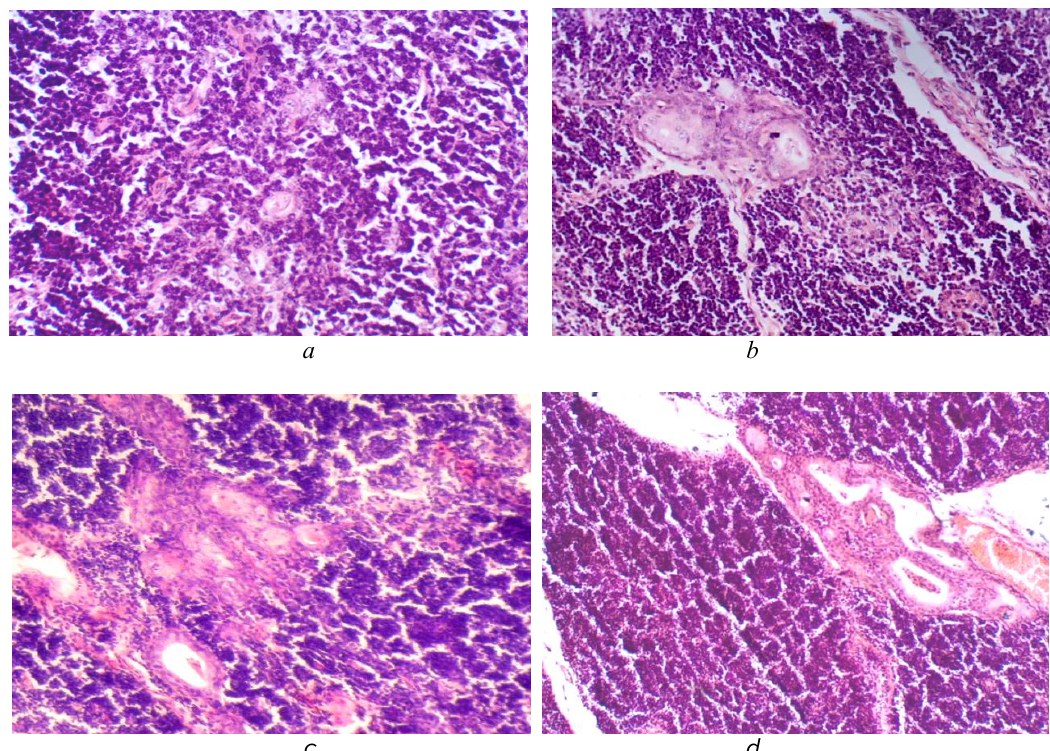
Fig. 1. Structure of the thymus of rats on the 18th day of the IC: a – thymus of rats IR; b – thymus of rats of CP; c – the thymus of rats against the background of the effect of TEPL at a dose of 100 mg/kg: d – thymus of rats against the background of the action of the preparation “Immuno-Ton” in a dose of 3 ml/kg Histologically, it was found that the lumbar structure few thymus cells (Fig. 1, a). In fig. 2 there are the structure of thymus intact animals is well expressed. In the brain of the spleen of rats on the 18th day of the CIS. substance among the lymphocytes, there are visible cells of In the spleen of intact animals, the hematopoietic the reticulo-epithelium with a large light nucleus, small and field was clearly divided into red and white pulp.